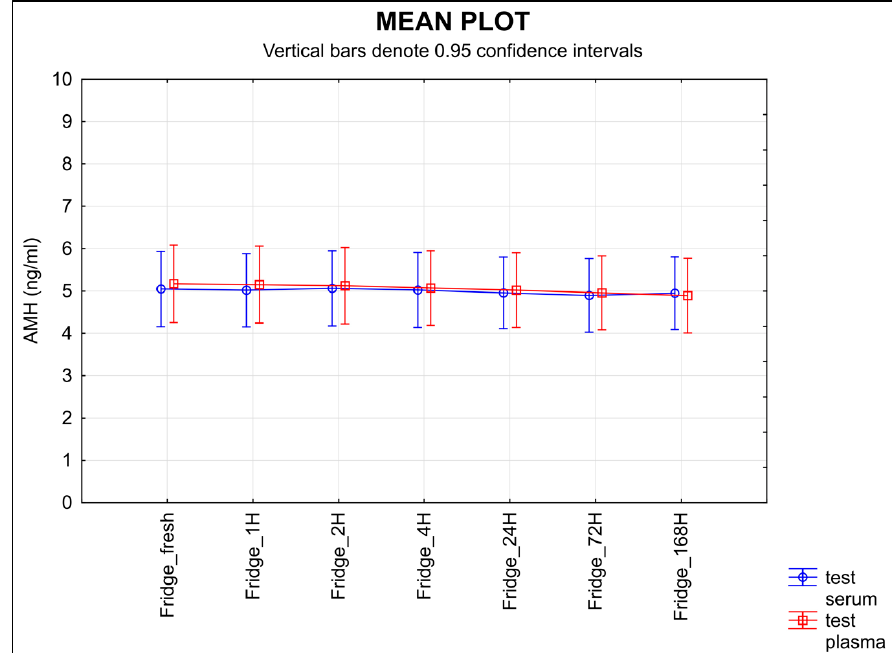
Figure 4. The stability of AMH after separation, stored at 4 ◦ C. Legend: The stability of AMH measured in the samples stored at 4 ◦ C after separation remained unchanged in the serum samples, whereas the level of AMH in the plasma samples decreased over time. An equivalence test using a ±0.30 ng/mL limit of tolerance found equivalence only for serum samples ( p = 0.0431), but not for plasma ( p = 0.3487).